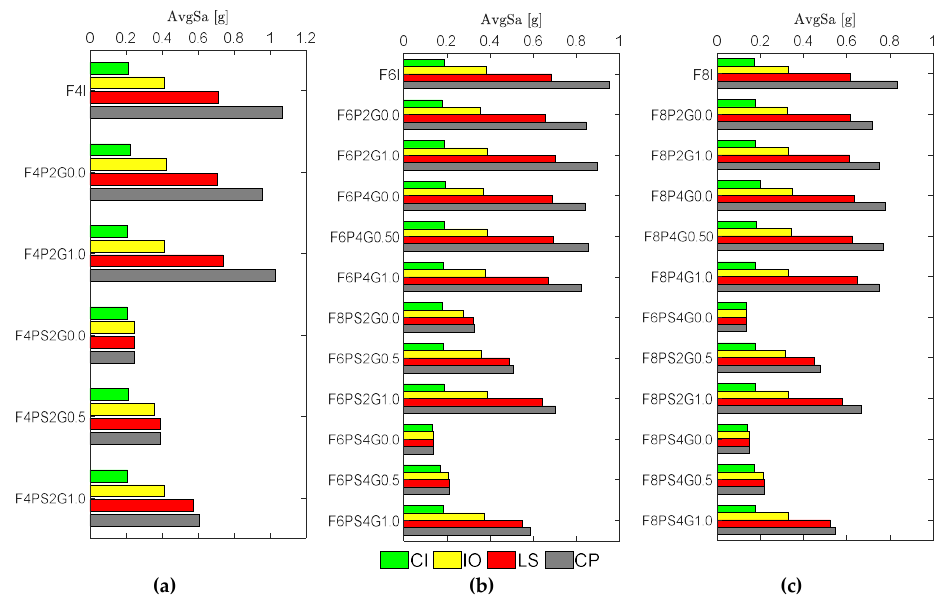
Figure 22. Fragility functions for different structures involving floor-to-column pounding and different values of the seis- mic separation distance ratio when the left-hand side structure is a 4-storey ( a ), 6-storey ( b ) and an 8-storey ( c ) building.